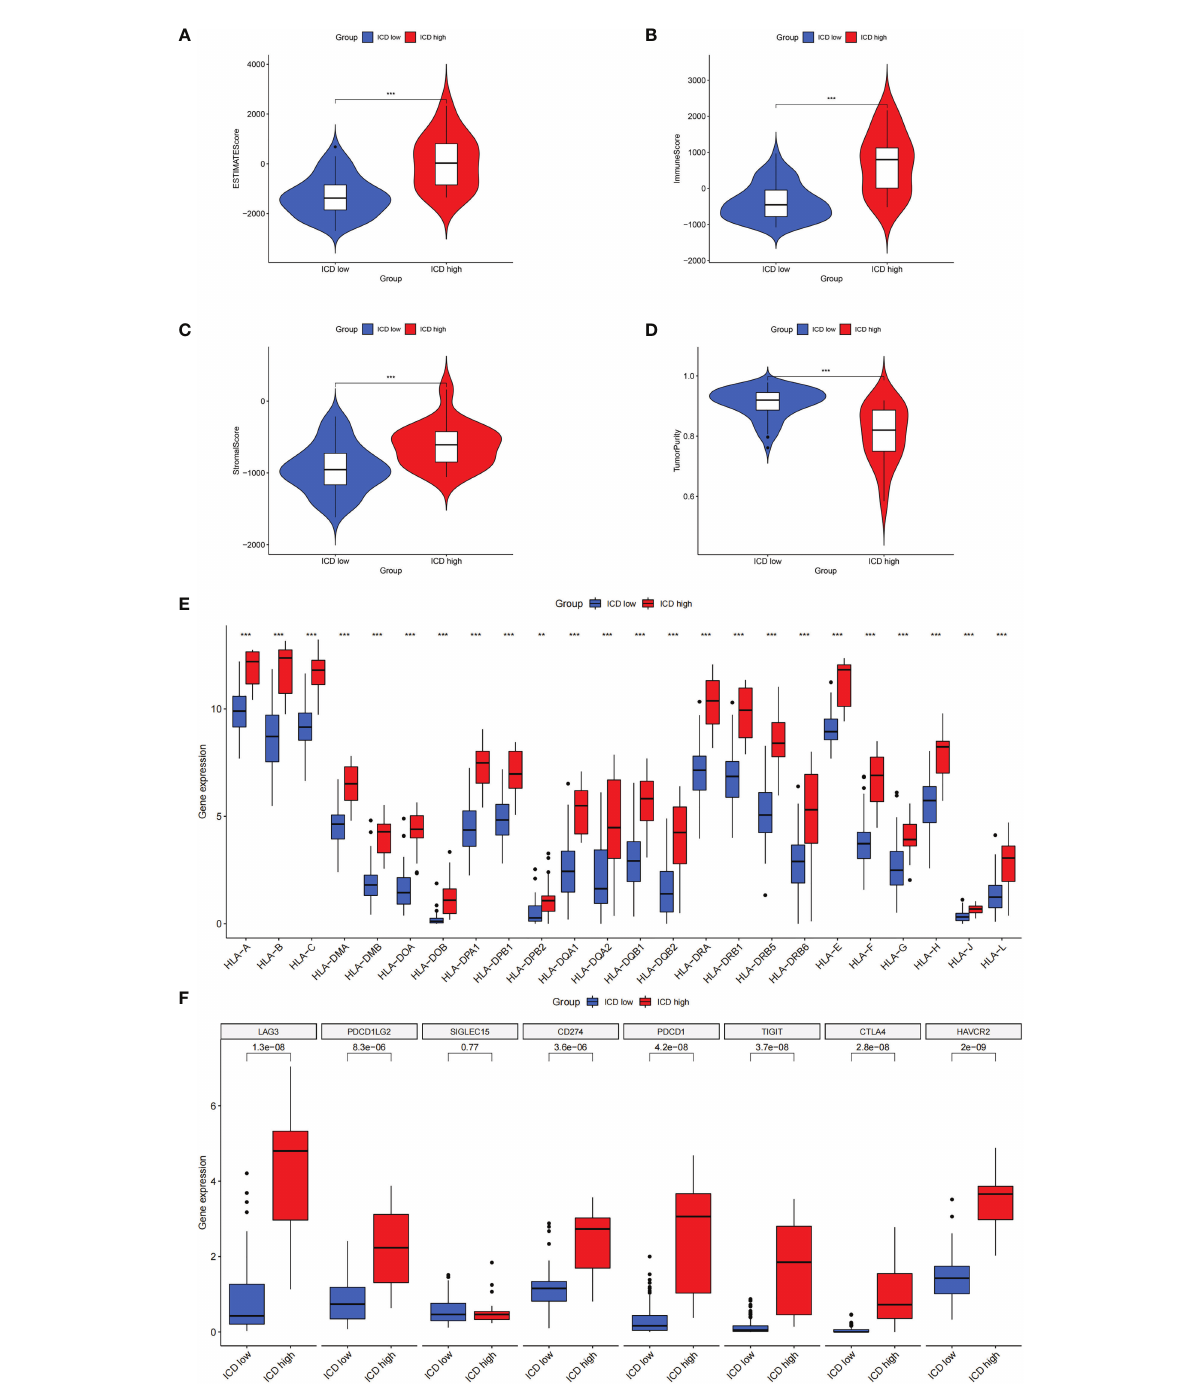
FIGURE 4 The characterization of immune landscape in different ICD clusters. (A-D) Violin plots of the stromal score, immune score, ESTIMATE score, and tumor purity between the high and low ICD expression groups. (E, F) Box plots of differential expressed immune checkpoints (F) and HLA genes (E) in two groups. **P< 0.01, ***P <